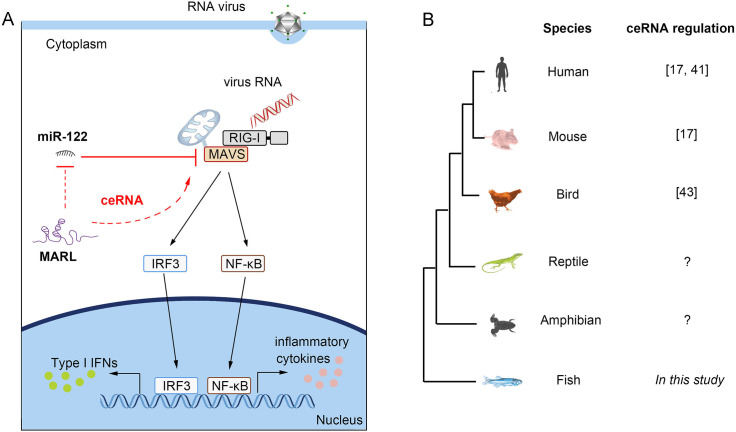
The mechanism graph of the regulatory network and function of MAVS.(A) Fish MAVS could induce the innate antiviral responses through recruiting NF-κB and IRF3 to trigger IFNs activation upon RNA viral infection. miR-122 targets MAVS and represses MAVS-mediated antiviral responses, thereby promoting viral replication. MARL act as a molecular sponge regulating miR-122 to enhance MAVS expression, thereby maintaining the stable of antiviral responses and ensuring appropriate inflammatory responses. (B) The ceRNA regulatory networks may exist wildly in vertebrate species.